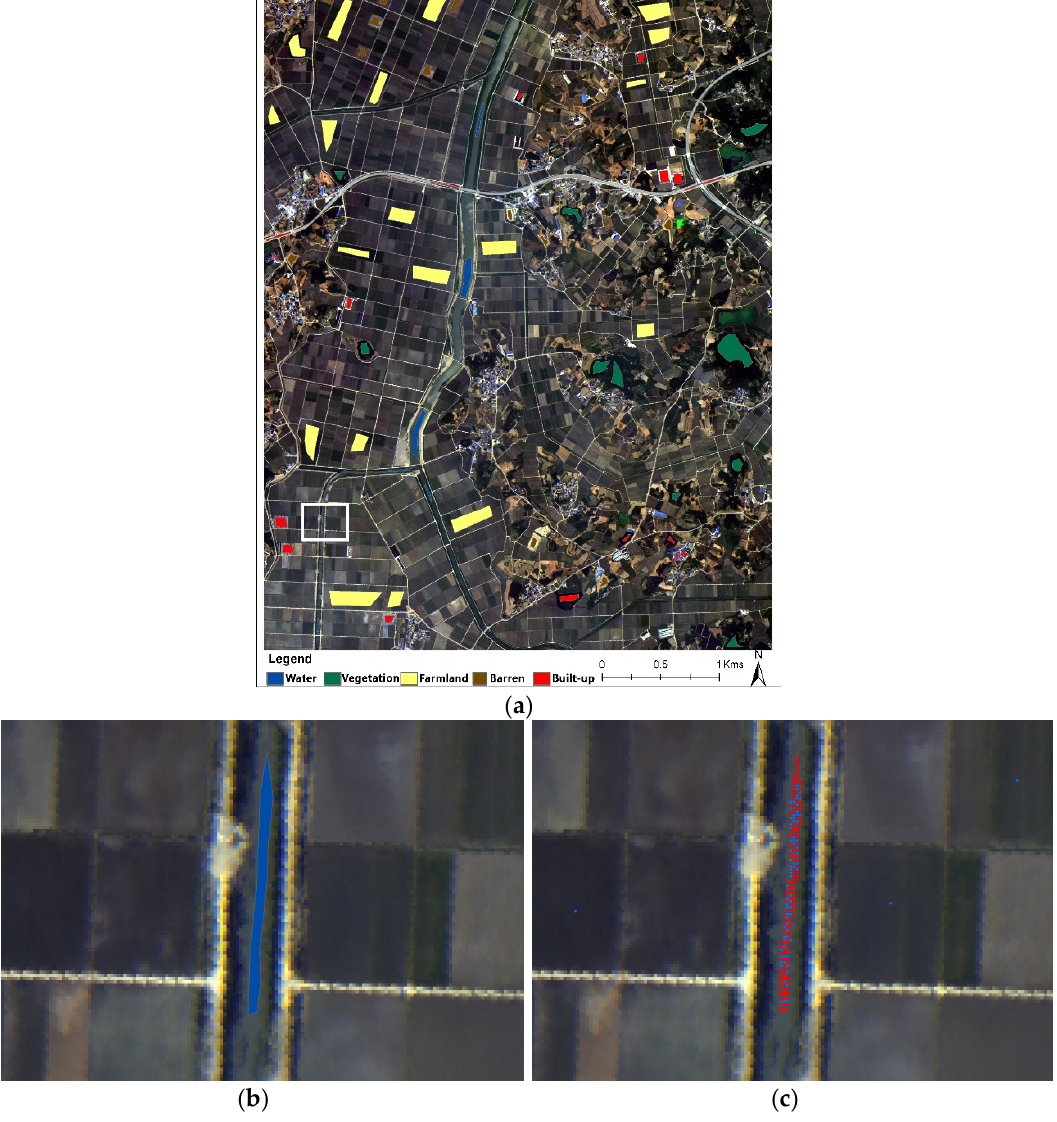
Figure 3. Sampling for training and validation: ( a ) Sampled polygons in the study area; ( b ) Zoomed view of a water polygon (white box on left-bottom of Figure 3a); ( c ) Zoomed area with training ( red ) and validation ( blue )